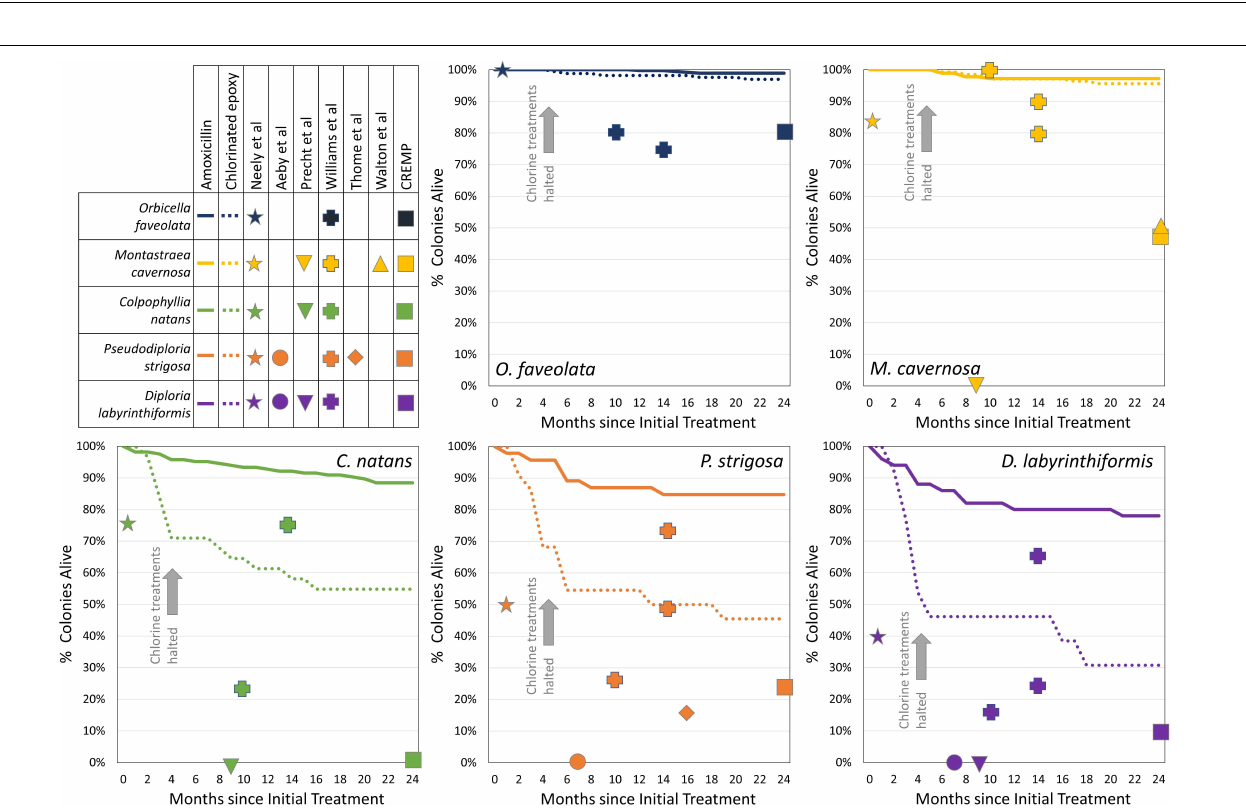
FIGURE 8 | Monthly survivorship curves for five coral species within the amoxicillin treatment regime (solid lines) and chlorinated epoxy treatment regime (dashed lines). Mortality of chlorinated epoxy-treated brain corals ( Colpophyllia natans , Pseudodiploria strigosa , and Diploria labyrinthiformis ) was rapid until all treatments were switched to amoxicillin 3 to 5 months after initial treatments. Species-specific mortality rates of corals at reported time points from other studies are indicated with shapes. Note that most other studies follow all corals within the population (including those which do not develop SCTLD), while the amoxicillin and chlorinated epoxy mortality curves follow only corals that were treated for